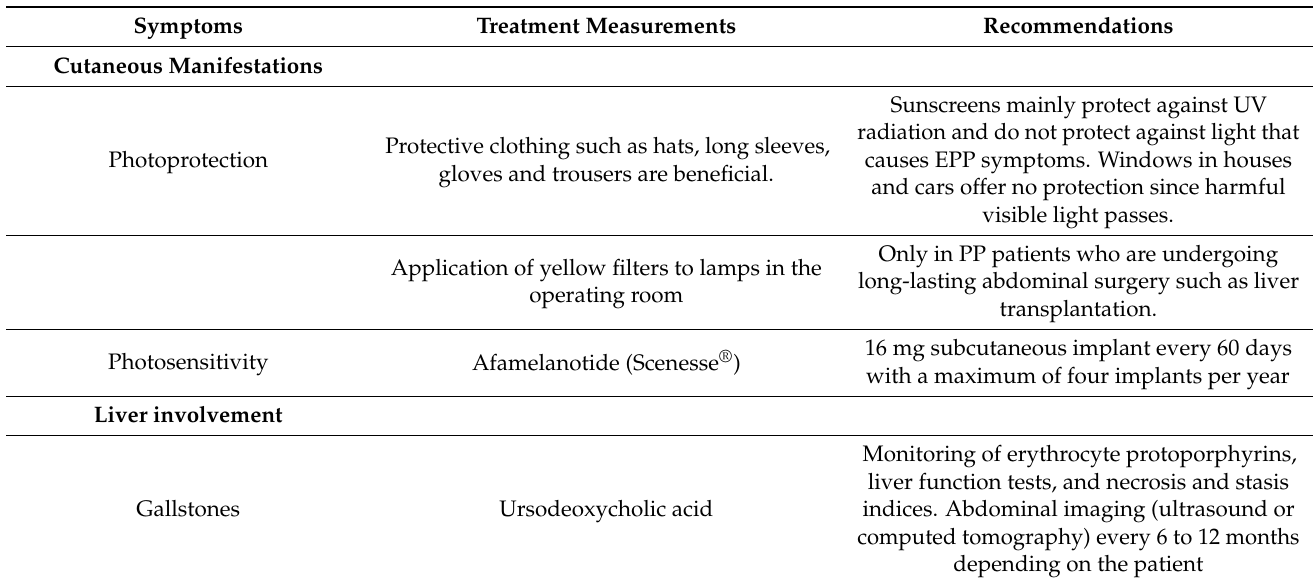
Table 1. Management and monitoring of